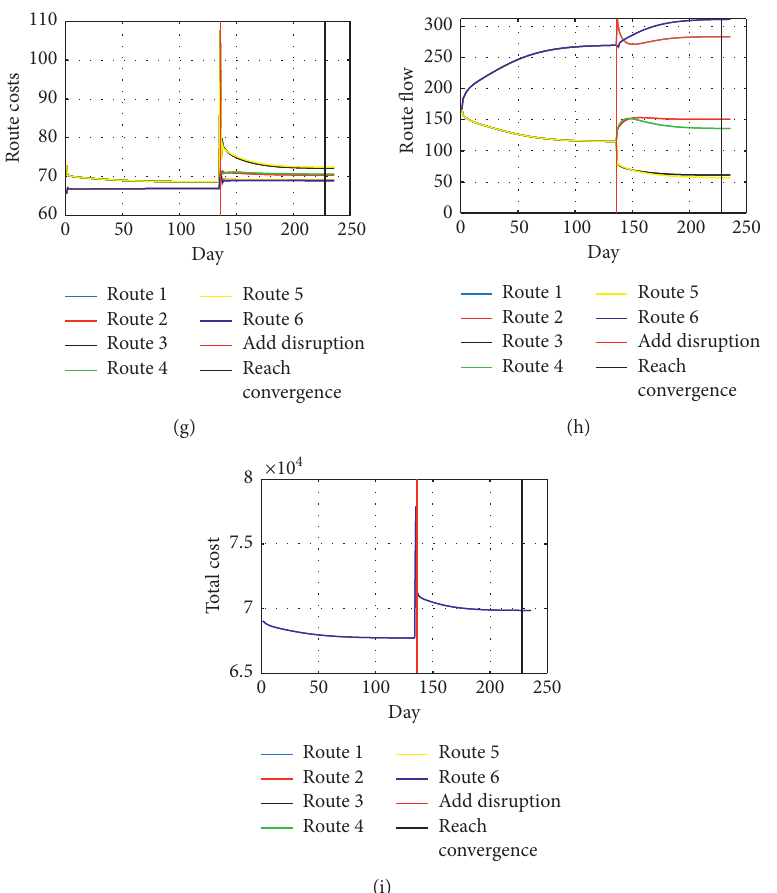
Figure 4: Evolution of route costs, route flow, and total cost under different levels of disruptions when the equisaturation ASC is employed. First row (from (a) to (c)): the evolution of route costs, route flow, and total cost when the capacity of link 9 reduces by 25%; second row (from (d) to (f)): the evolution of route costs, route flow, and total cost when the capacity of link 9 reduces by 50%; third row (from (g) to (i)): the evolution of route costs, route flow, and total cost when the capacity of link 9 reduces by